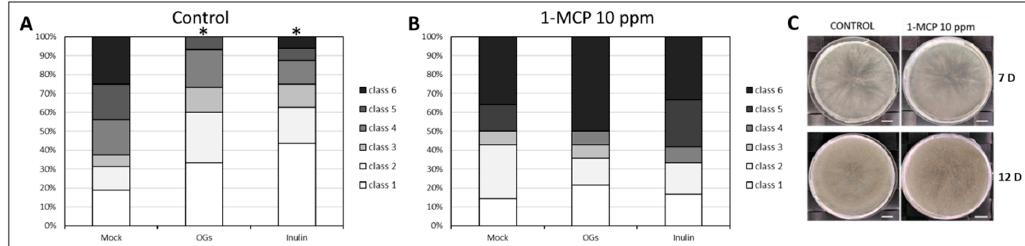
Figure 5. Effect of 1-methylcyclopropene (1-MCP) treatment on basal and OGs- and inulin-induced protection against Botrytis cinerea . ( A ) Disease scoring results of primed leaves not treated with 1-MCP; ( B ) Disease scoring results of primed leaves treated for 24 h with 10 ppm 1-MCP before pathogen inoculation. Asterisks indicate significance against mock ( p < 0.05, Mann–Whitney u -test). This experiment was repeated three times with consistent results; ( C ) Representative pictures of Botrytis cinerea growth assay on PDA plates after a treatment with 10 ppm 1-MCP, with pictures taken 7 days (7 D) and 12 days (12 D) after plate inoculation. Bars = 1 cm.